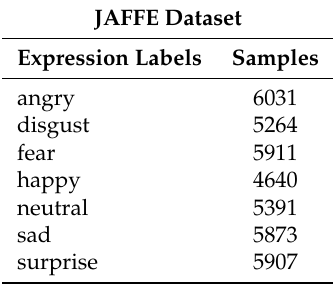
Figure 10. Some images of JAFFE database. From left to right: anger, disgust, fear, happiness, neutrality, sadness and surprise. Table 1. This table describes the sample number of JAFFE database.